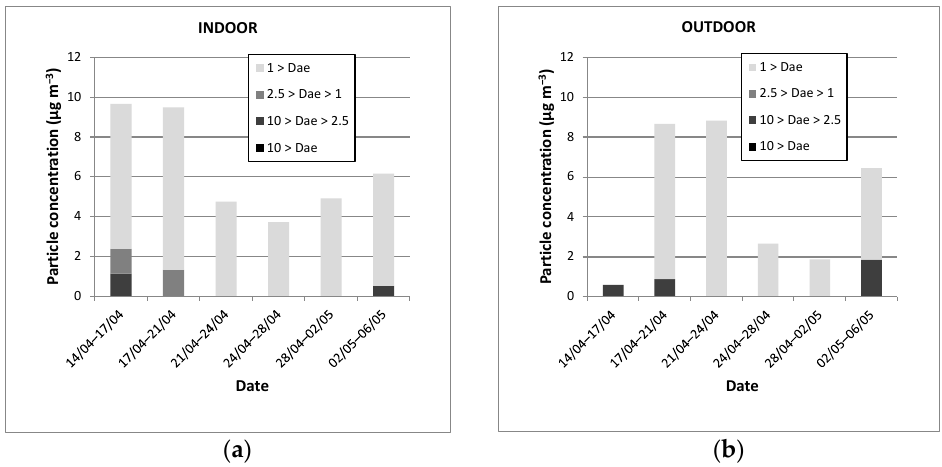
Figure 3. Particulate matter mass concentrations ( µ g m − 3 ) measured in 2014 vs. time obtained either indoors ( a ) or outdoors ( b ) related to the collection plate and therefore the particulate size (Dae).